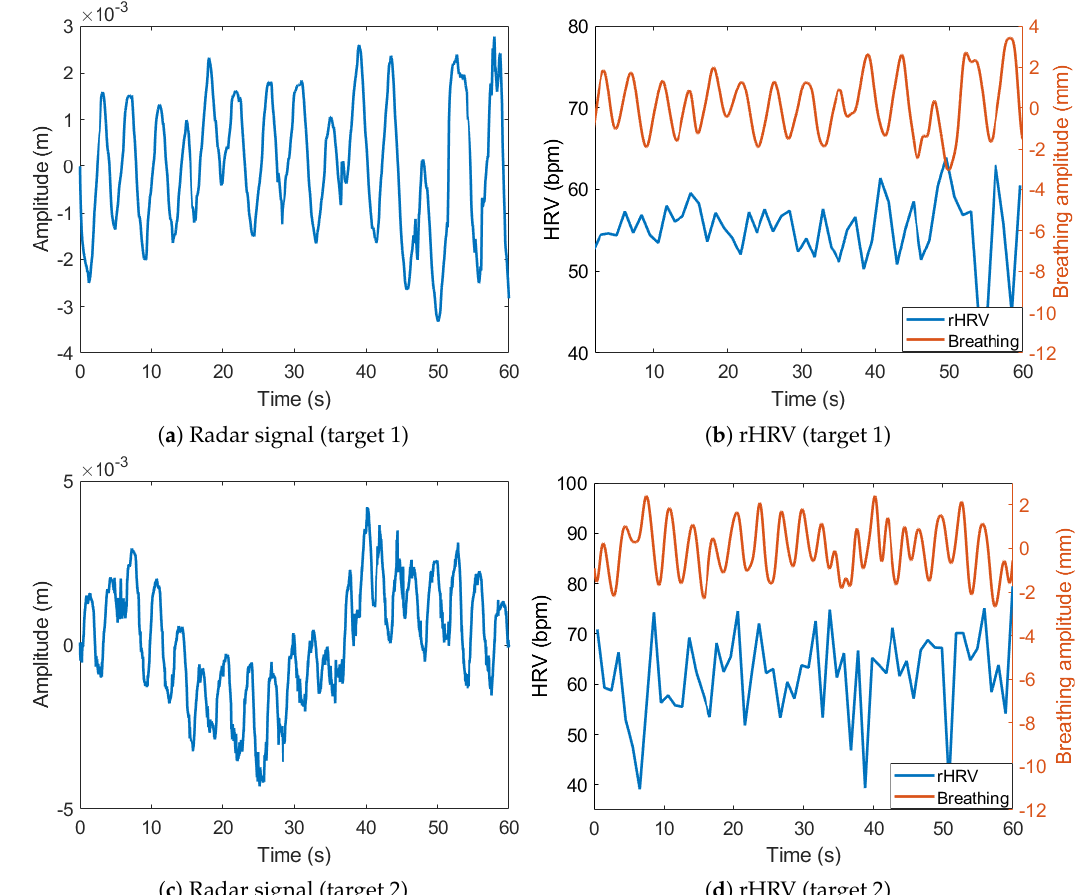
Figure 18. ( a ) Radar signal obtained from target 1 after performing the pre-processing algorithm. ( b ) rHRV extracted from the target located at 1.2 m. ( c ) Radar signal obtained from target 2 after the pre-processing algorithm. ( d ) rHRV extracted from the target which is located at 1.6